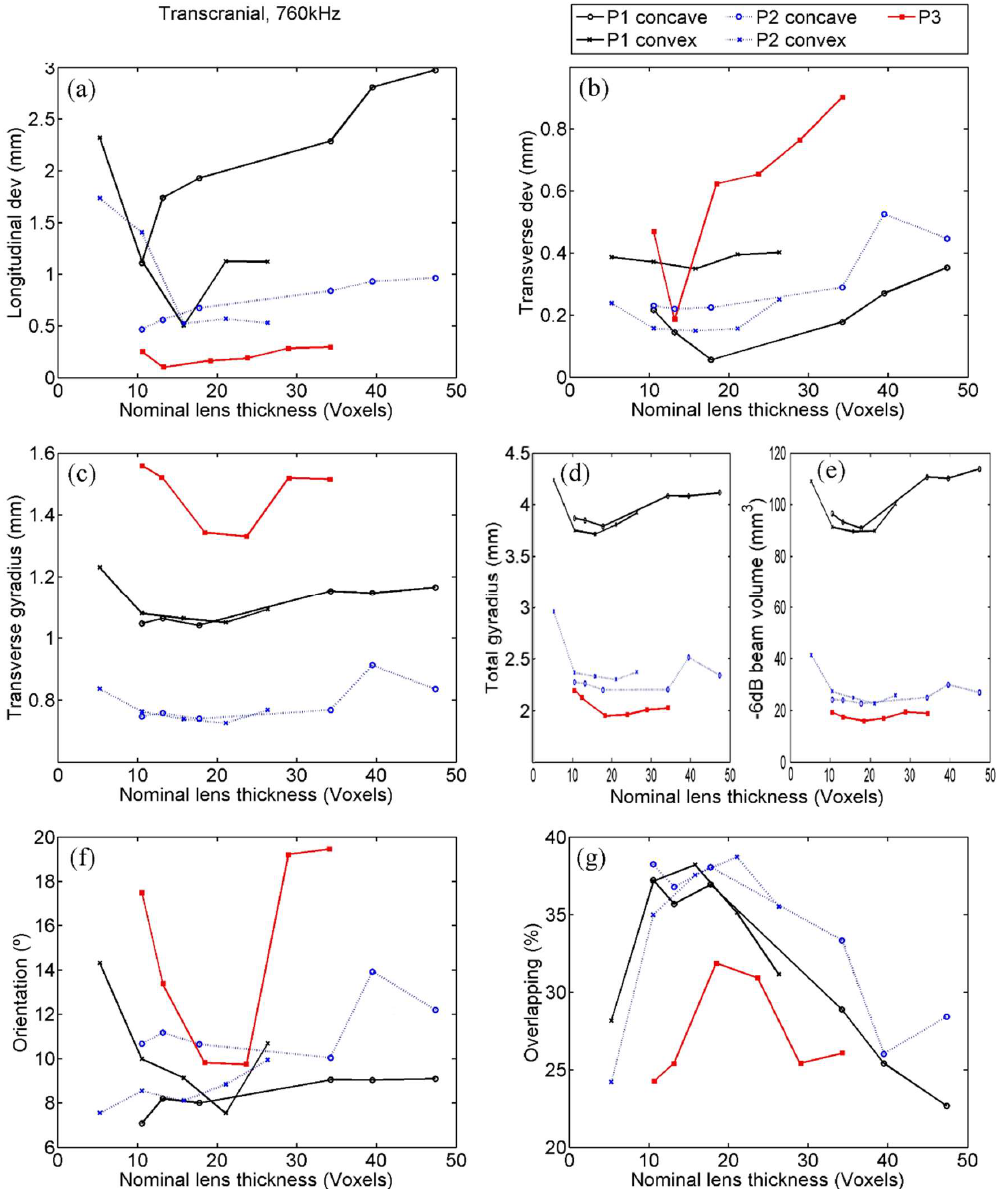
Figure 6. Focusing quality indicators calculated by transcranial simulation with 760 kHz at points P1, P2, and P3, for concave (fast) and convex (slow) lenses. Indicators are as follows: ( a ) Longitudinal and ( b ) transverse deviation, ( c ) transverse and ( d ) total gyradius, ( e ) beam volume, ( f ) orientation, and ( g ) energetic overlapping.